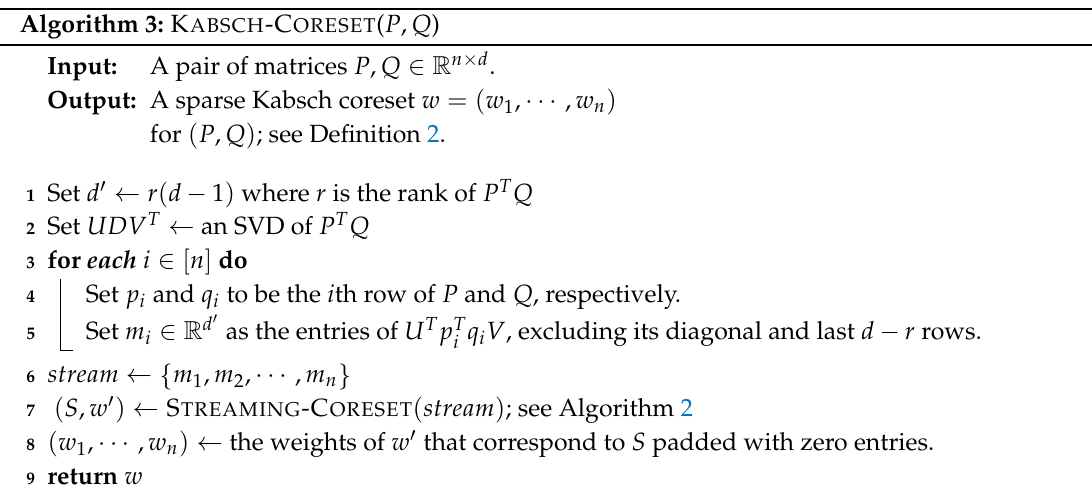
Algorithm 3: K ABSCH -C ORESET ( P , Q